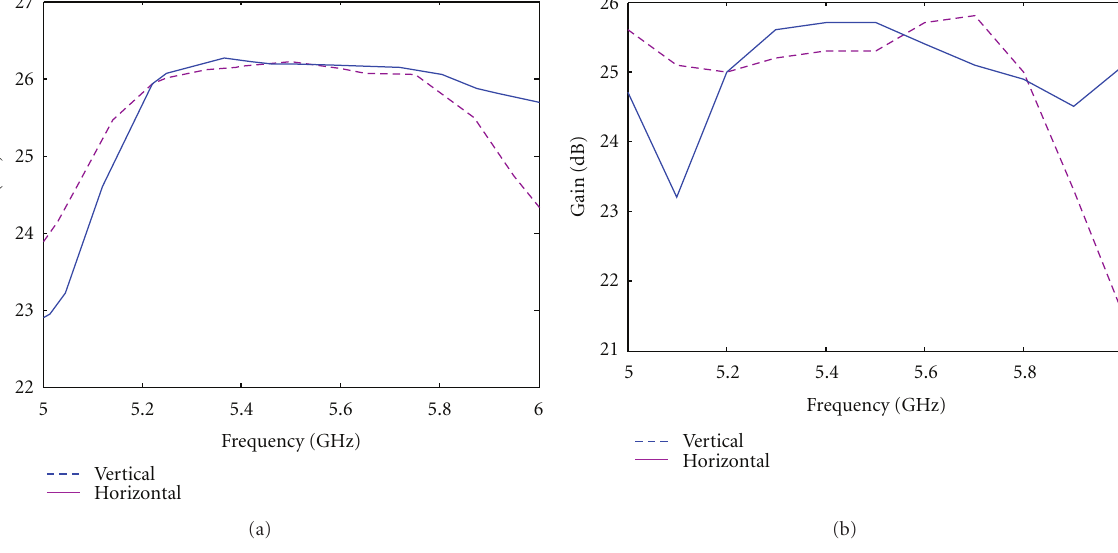
with h f = 0 . 762 mm, ε r f = 4 . 5) are